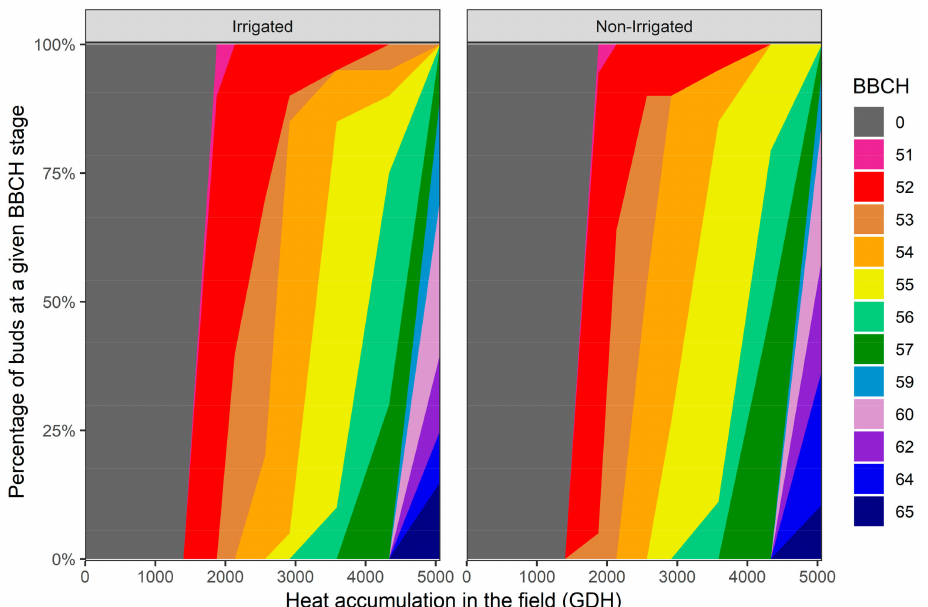
Figure 7. Phenology progression of the apical buds in apple trees cv. ‘Elstar’ grown in Campus Klein-Altendorf exposed to two irrigation regimes (‘irrigated’ and ‘non-irrigated’ panels) during the growing season of 2018. The x -axis represents the accumulation of heat (in Growing Degree Hours (GDHs)) under field conditions after a minimum chill requirement of 50 CP had been fulfilled. The colors represent the sub-stages for the principal growth stages 5 (inflorescence emergence) and 6 (flowering) of reproductive buds, according to the BBCH scale. We monitored 208 apical buds in total.